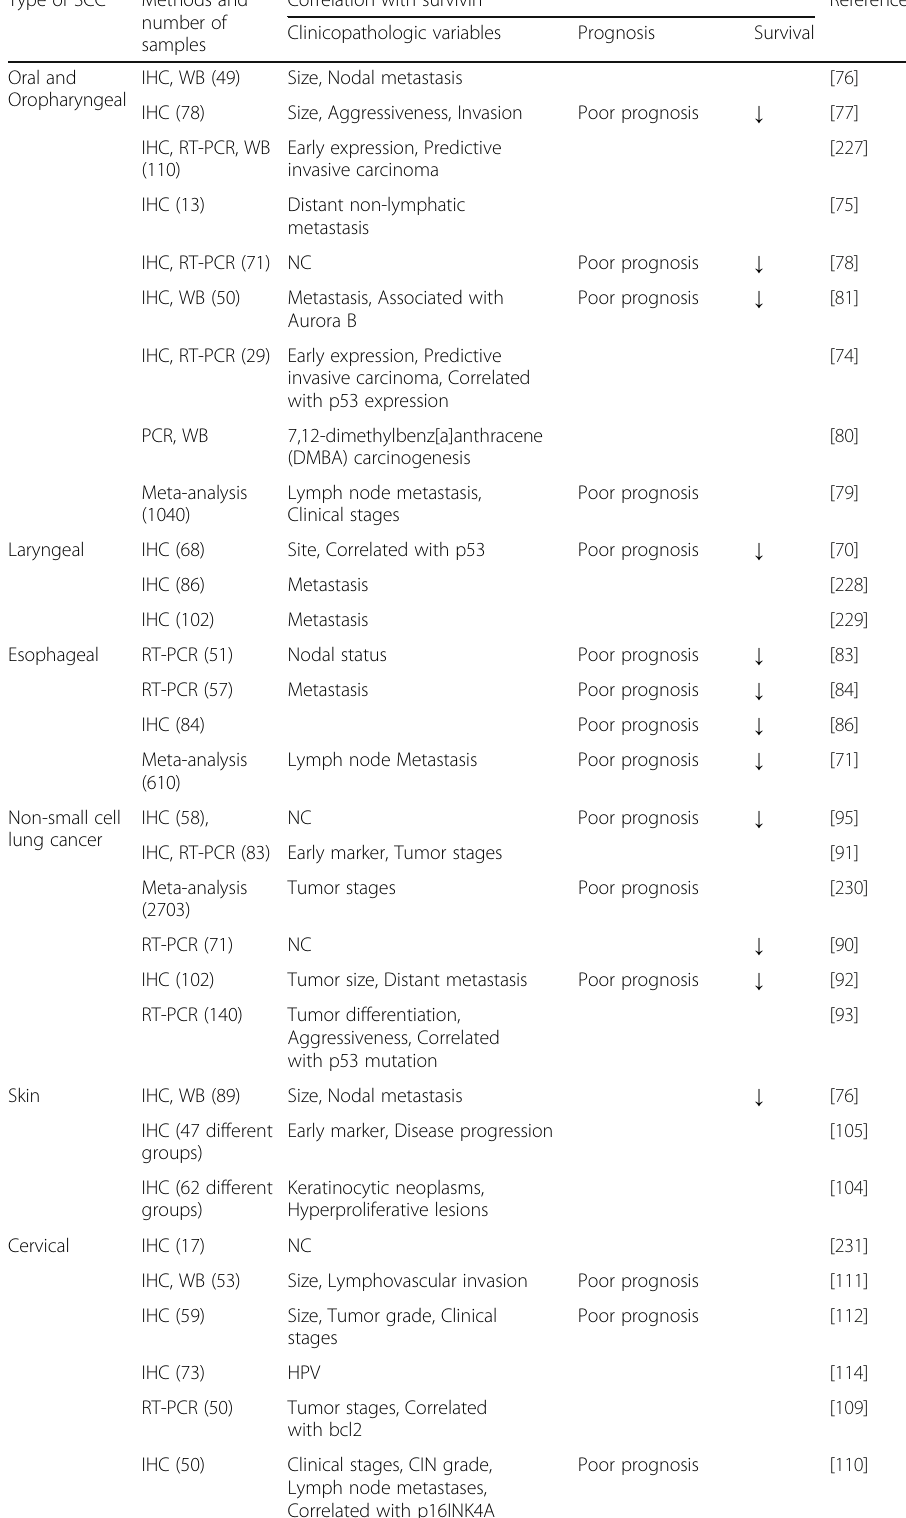
Table 1 Expression of survivin in SCCs. NC- no statistical correlation, IHC-immunohistochemistry, RT-PCR- reverse transcriptase, WB-western